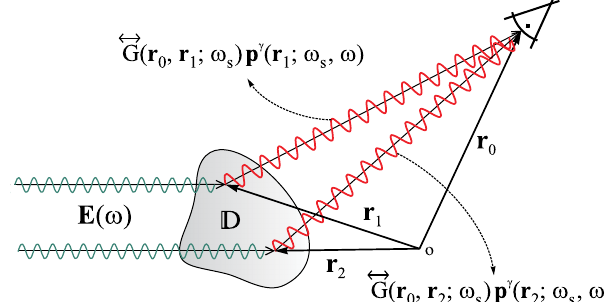
FIG. 1. Illustration of two individual scattering paths associated with a scatterer D irradiated by the field E ð ω Þ . On length scales j r 1 − r 2 j smaller than the phonon correlation length L of a vibrational mode γ , the partial fields c ↔ ↔ G ð r 0 ; r 1 ; ω s Þ p γ ð r 1 ; ω s ; ω Þ and G ð r 0 ; r 2 ; ω s Þ p γ ð r 2 ; ω s ; ω Þ add co- herently at location r 0 of the detector. On the other hand, for length scales larger than L , there is no phase correlation between c the scattering events; hence, the partial fields at the detector add